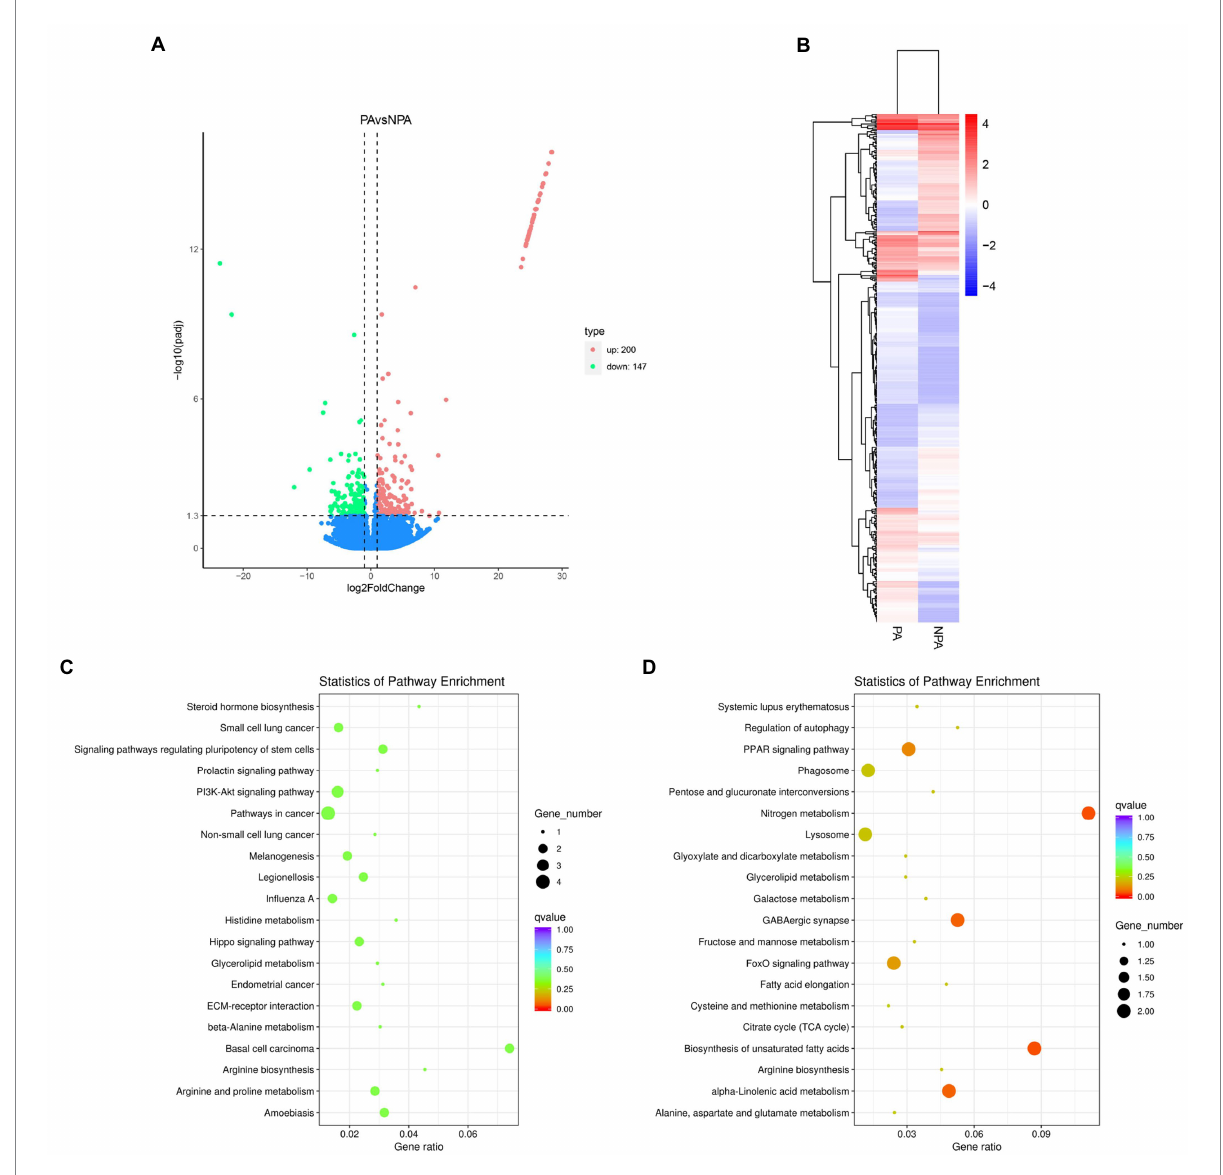
FIGURE 3 Differentially expressed genes (DEGs) in gill of deep-sea mussels G. haimaensis transcriptome between NPA and PA. (A) Volcano plot displaying DEGs between NPA and PA group. The green dots and red dots represent downregulated and upregulated DEGs, respectively. A total of 347 unigenes were identified as differentially expressed. (B) Hierarchical clustering analysis for the differentially express genes between PA and NPA transcriptomes. The horizontal lines represent the expression pattern of each gene, and the vertical rows represent PA and NPA samples. The expression level is represented by color intensities (red color indicates the higher expression, and blue color indicates the lower expression of the gene). (C) Downregulated DEGs enriched in KEGG pathways. (D) KEGG enrichment analysis of annotated DEGs, Upregulated DEGs enriched in KEGG